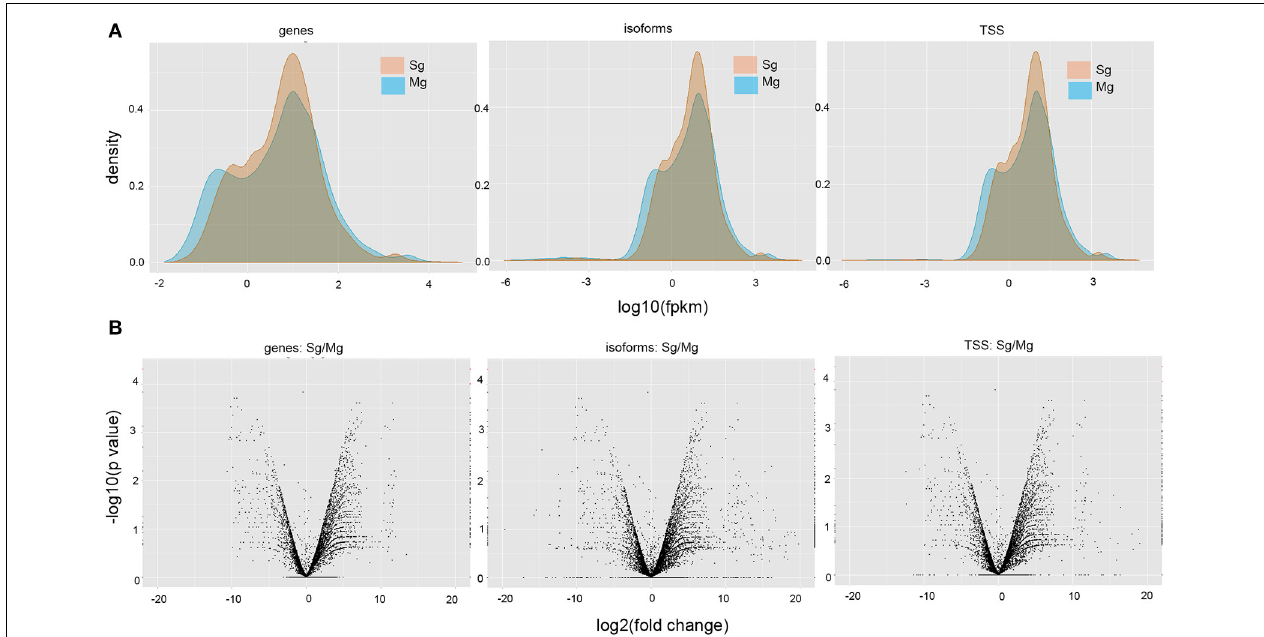
FIGURE 1 | Differential expression analyses between midgut and salivary gland samples of A. gambiae. (A) Volcano plots displaying changes in gene expression, isoforms, and TSS usage (log2-fold change). Each symbol represents one gene that has detectable expression in either tissue. Relative differences in signal intensity along the X-axis reflect up-regulation in salivary glands when positive and up-regulation in